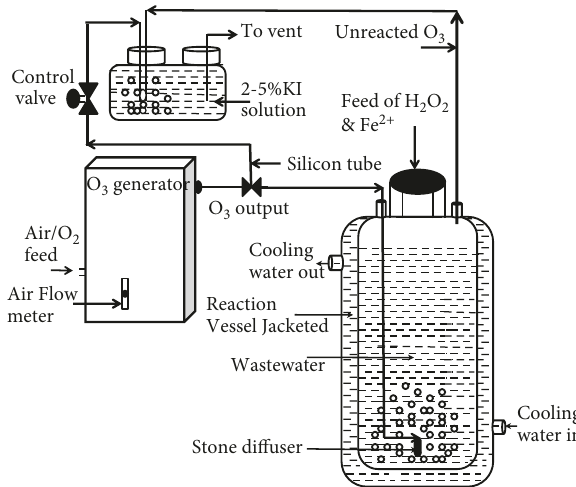
Figure 1: Experimental setup of the O